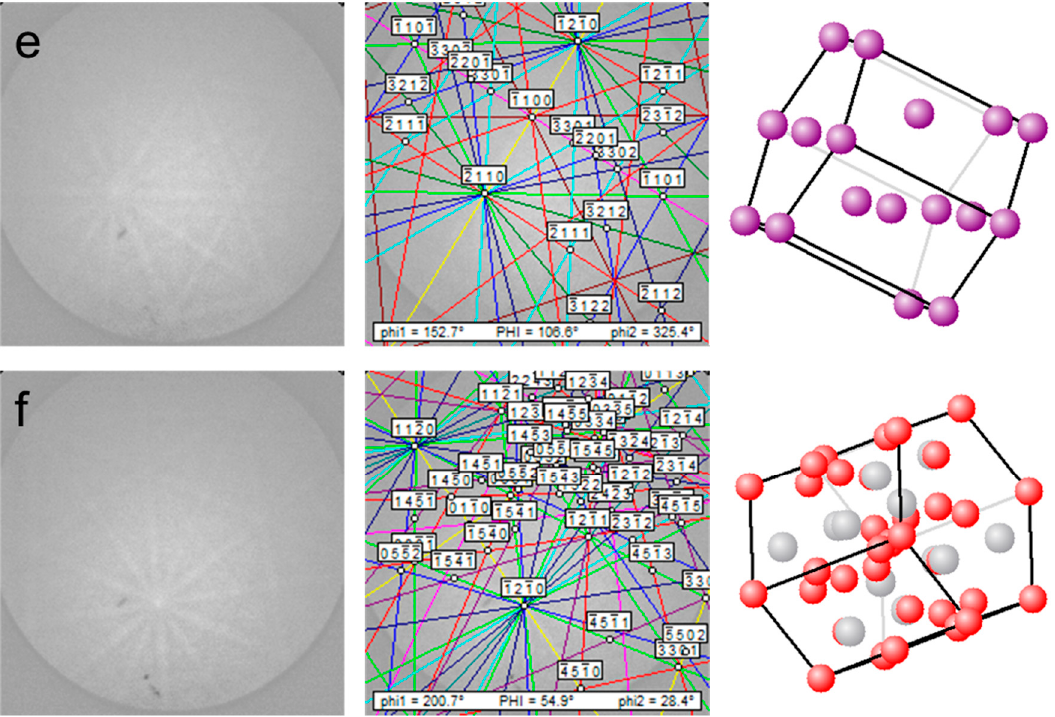
Figure 3. Original EBSD patterns, fitted patterns, and simulations of grain orientation from spots ( a ) Z1: LaNi 5 ; ( b ) Z2: Ce 2 Ni 7 ; ( c ) Z3: Pr 2 Ni 7 ; ( d ) Z4: CeNi 3 ; ( e ) Z5: Mg; and ( f ) Z6: NbCr 2 of the 8-h annealed sample (Figure 2).